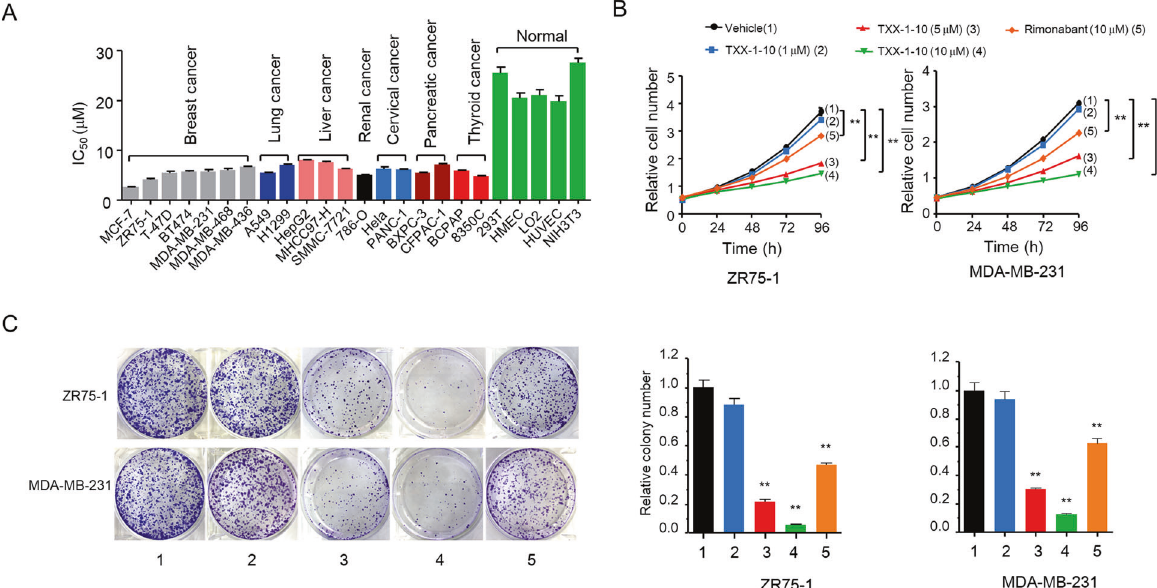
Fig. 2 TXX-1-10 inhibits cancer cell proliferation. A IC 50 values of TXX-1-10 in 24 cell lines were determined by the CCK8 assay. B The proliferation curve of ZR75-1 and MDA-MB-231 cells treated with indicated concentrations TXX-1-10, rimonabant or vehicle control (DMSO). C Colony formation assays for ZR75-1 and MDA-MB-231 cells treated as in B . Histograms show the colony number (right panel). Data shown are mean ± SD of triplicate measurements that have been repeated three times with similar results. Statistical signi fi cance was assessed by two-tailed Student ’ s t test. * p < 0.05, ** p < 0.01 versus the corresponding